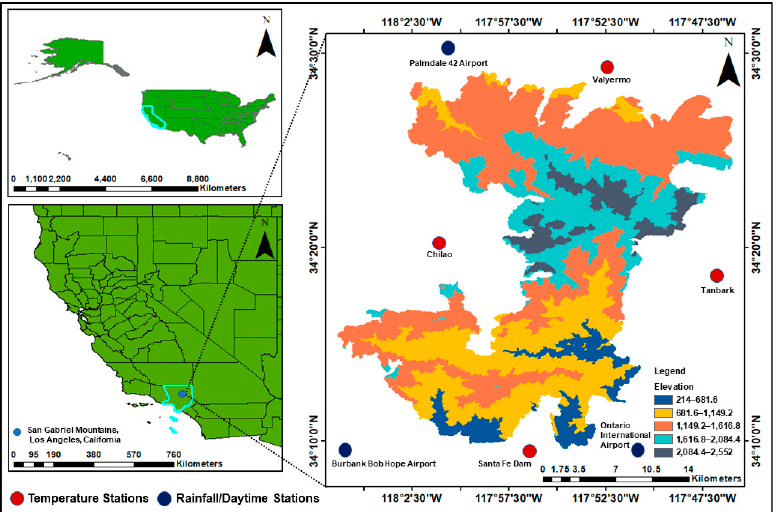
Figure 1. The geographical location of the study area.